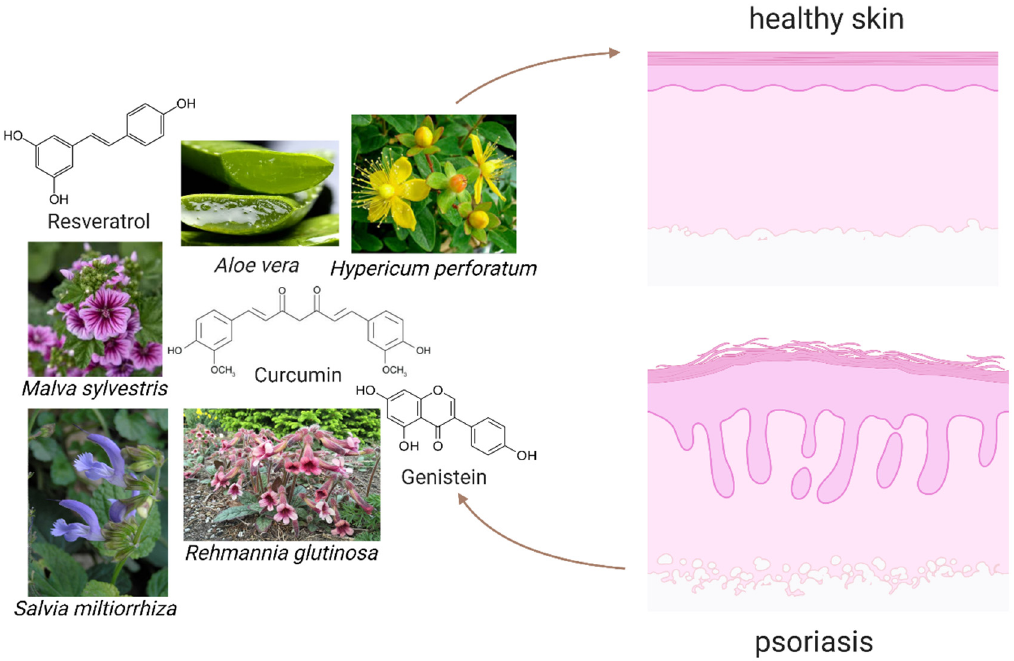
Figure 2. The scheme demonstrating the chosen plants and phytochemicals that may help to reduce symptoms of psoriasis, and act as antiproliferative compounds for psoriatic keratinocytes.